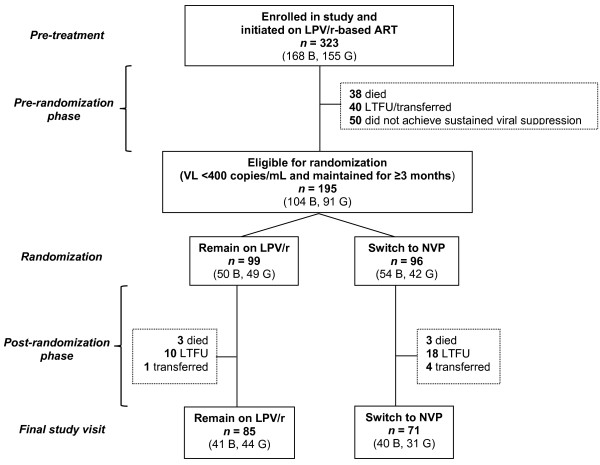
Flow diagram of study participants in Neverest 2. Flow diagram of study participants in Neverest 2; Abbreviations: LPV/r, lopinavir-boosted ritonavir; NVP, nevirapine; ART, antiretroviral therapy; LTFU, lost to follow up; B, boys; G, girls.